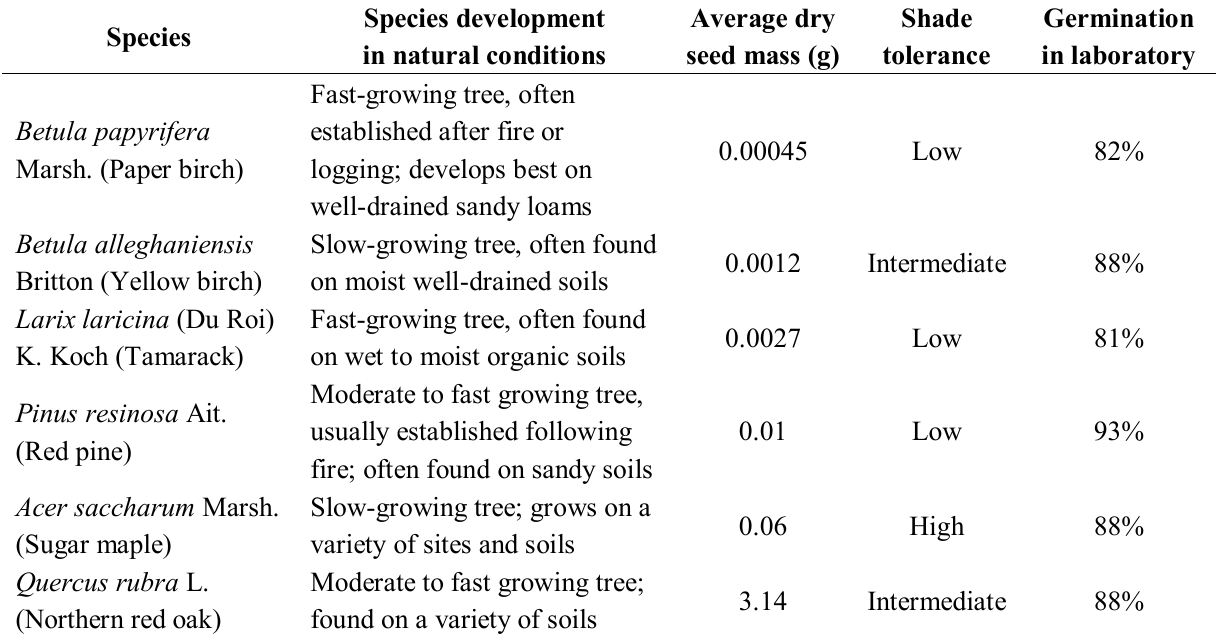
Table 1. Characteristics and seed germination in the laboratory of the six tree species tested. Species development Species in natural conditions Fast-growing tree, often Betula papyrifera established after fire or Marsh. (Paper birch) logging; develops best on well-drained sandy loams Slow-growing tree, often found on moist well-drained soils on wet to moist organic soils Moderate to fast growing tree, usually established following 0.01 Low